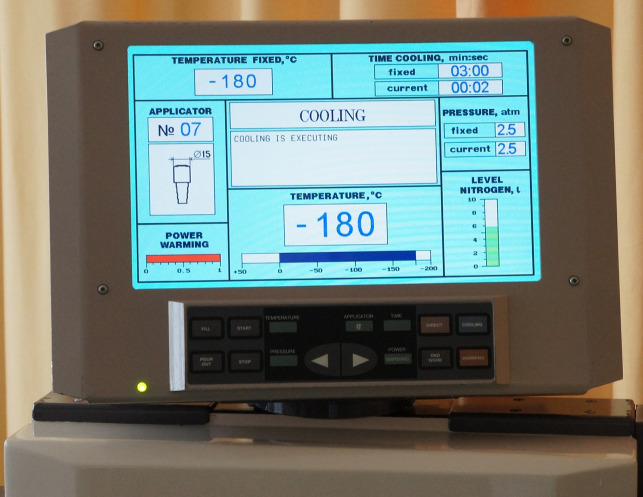
Mobile universal cryogenic complex (UCC) based on liquid nitrogen as the refrigerant produced by CryoPulse Co., Kyiv, Ukraine.View of electronic device display.